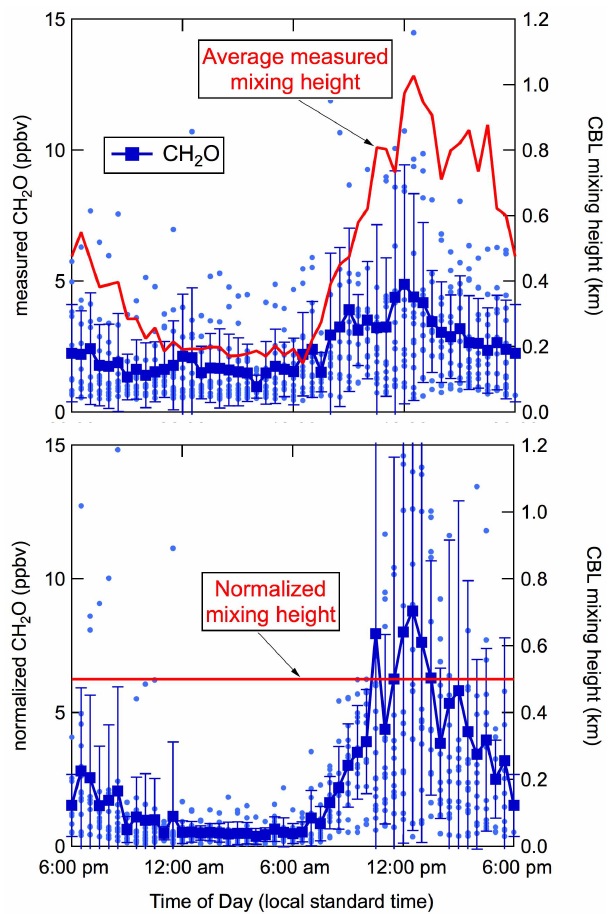
Fig. 7. CH 2 O concentrations and mixing heights measured aboard the NOAA research vessel Ronald H. Brown during TexAQS 2006 within the HGB area. (a) The light blue points include all 30-min averages recorded during the study, and the dark blue symbols in- dicate averages and standard deviations for 30 min diurnal periods. The red line indicates average mixing height (i.e. CBL depth) (b) The calculated CH 2 O concentrations expected if the integrated col- umn concentration in (a) were uniformly mixed to a constant mix- ing height of 500m (after Gilman et al., 2009).